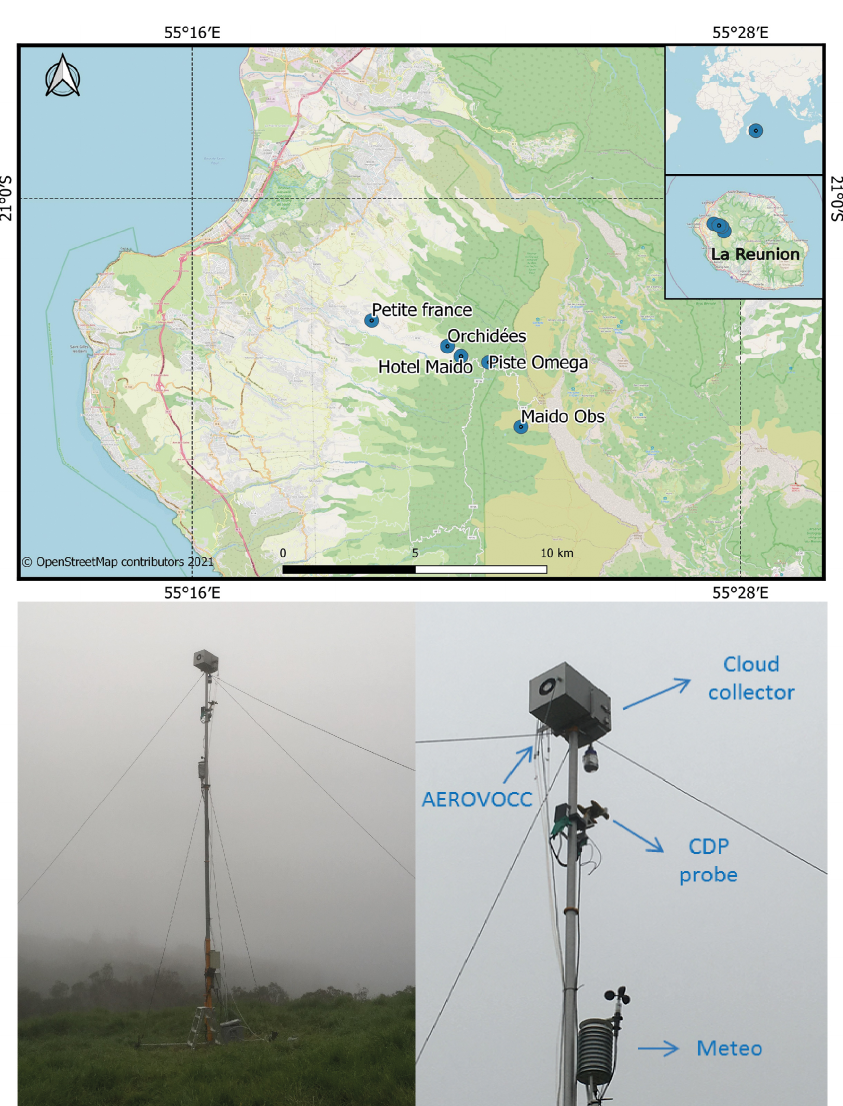
Figure 1. Locations of Piste Omega and other instrumented sampling sites in Réunion. Photo of the mast (10m height) deployed during the BIO-MAÏDO project integrating the cloud water collector, cloud droplet probe (“CDP”), meteorological station (“Meteo”), and gas-phase collection